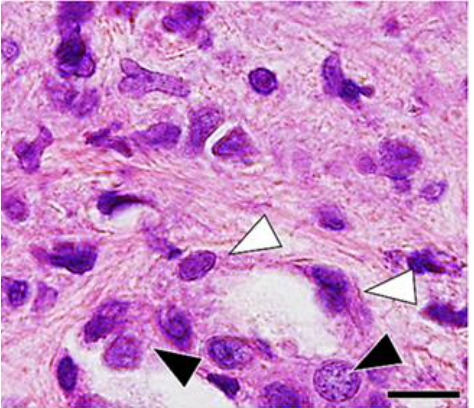
Figure 4. Microscopic findings of the fibrotic lesion of the lung tissue at 12 months after silica treatment, showing hyperplasia of type II epithelial cells (black arrow heads) with frequent appearance of spindle and elongated shape (white arrow heads). Hematoxylin and eosin. Bar = 20 μm.